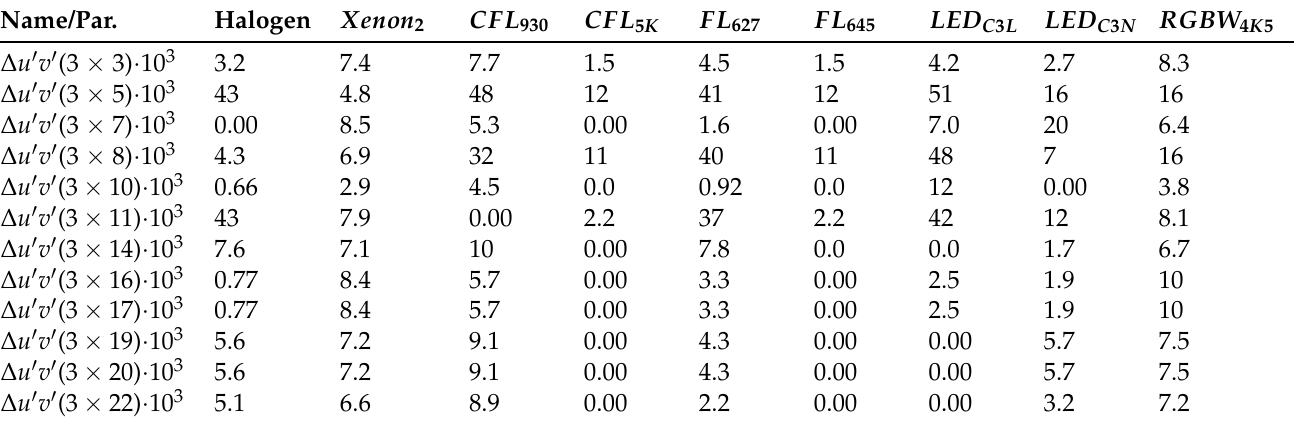
Table 2. Remaining color differences after optimization for different sizes of the corresponding transformation matrix applied to the artificial light sources’ training database Name/Par.